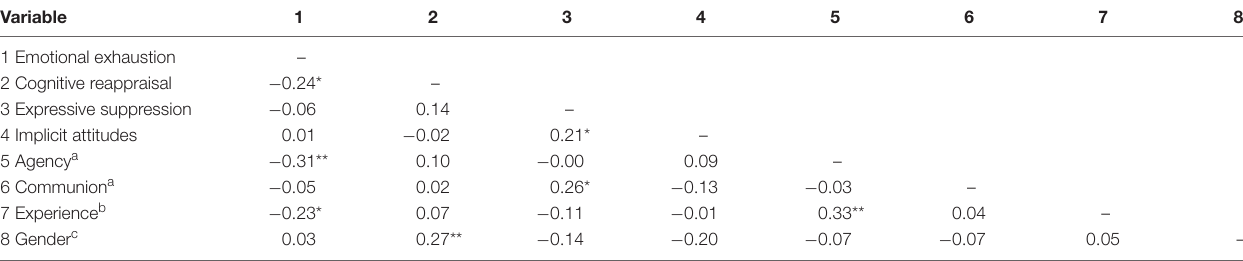
TABLE 5 | Pearson correlations for the full sample ( N = 94). Variable